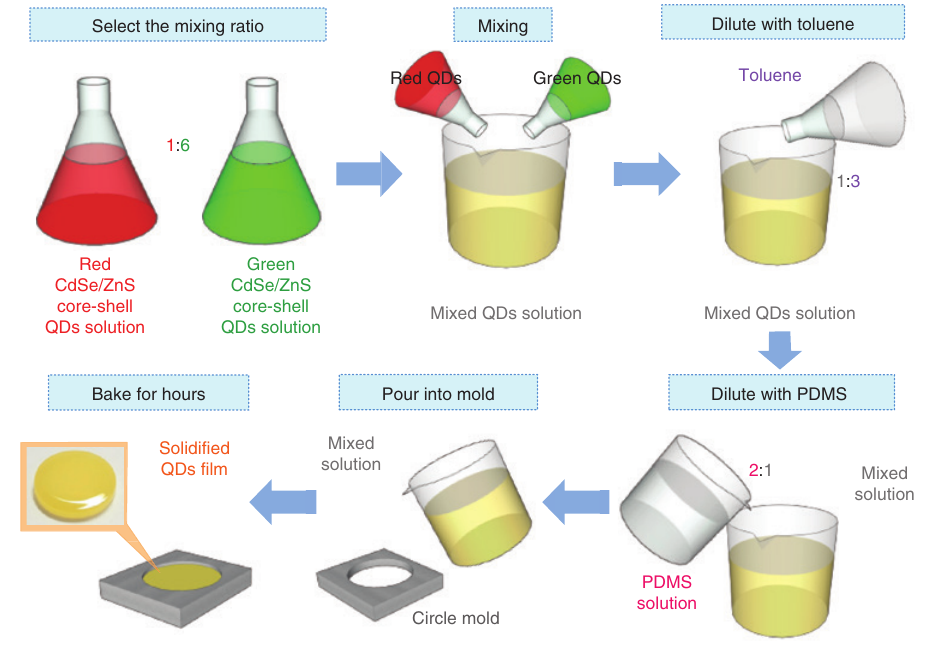
Figure 2: Fabrication method of CdSe/ZnS core-shell-QD doped PDMS